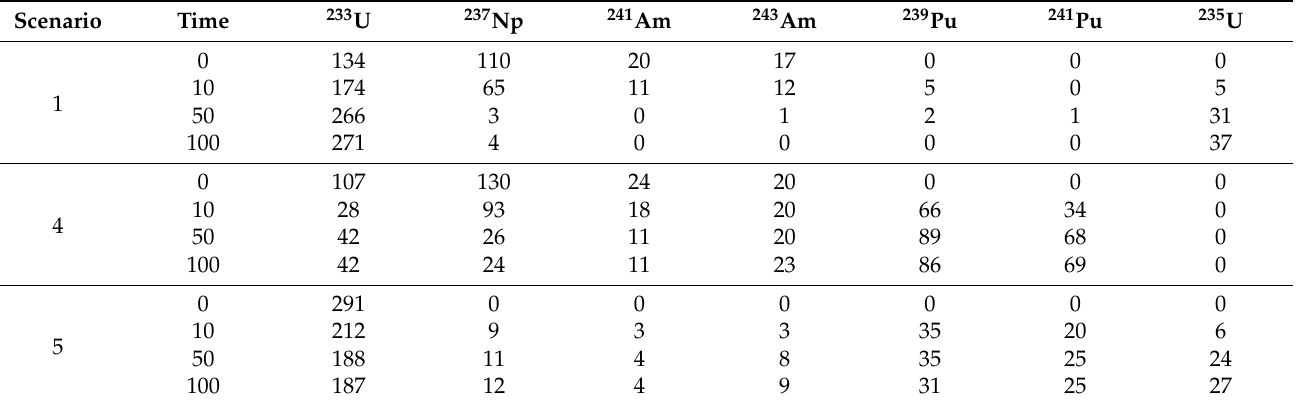
Table 5. The β s of main nuclides for different scenarios with different depletion time (unit: years, pcm).